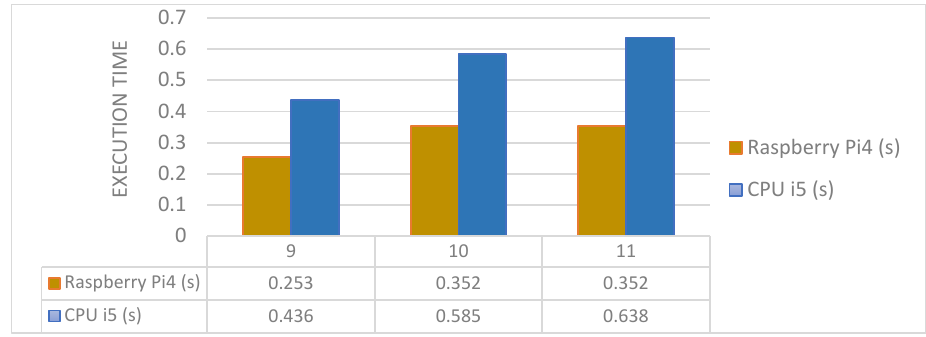
Figure 12. Run time performance of Raspberry Pi 4 compared to CPU i5 according to patch size .